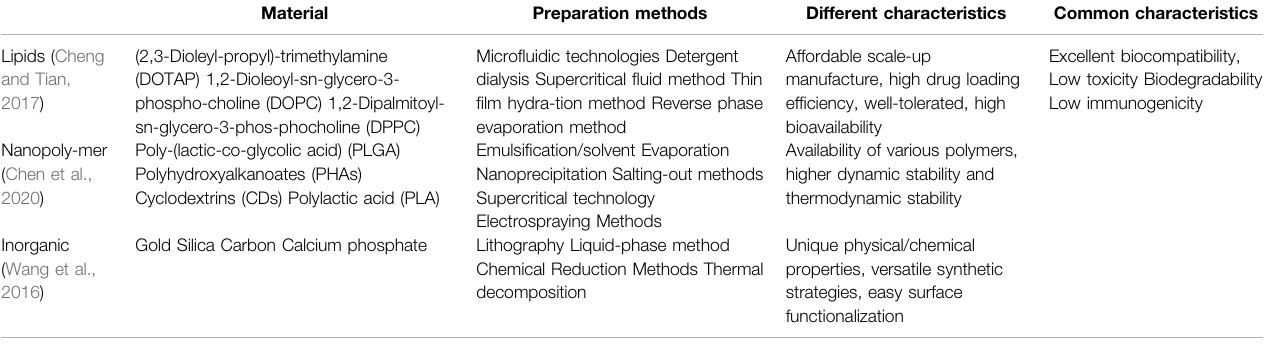
TABLE 2 | Nanoparticle preparation materials, methods and characteristics. Material